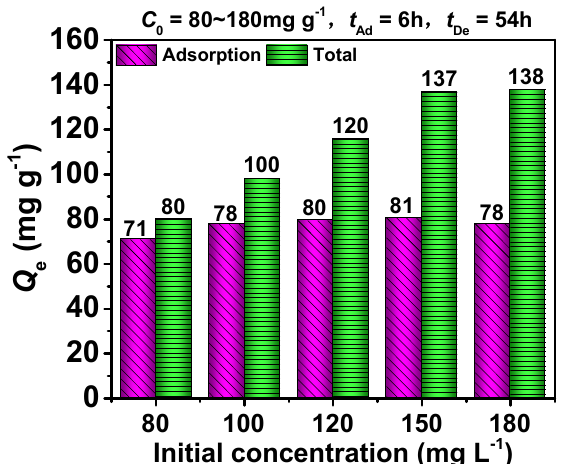
Figure 9. Effect of initial concentration on the degradation of MB by mesoporous Co–SiO 2 (0.17) catalyst.